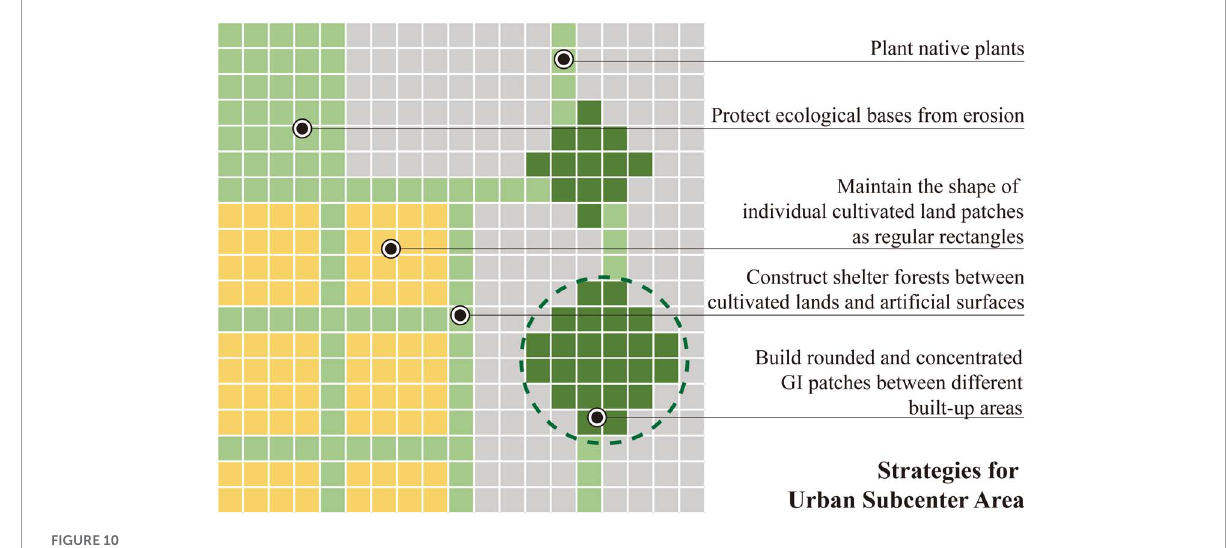
FIGURE10 Strategies for urban subcenter